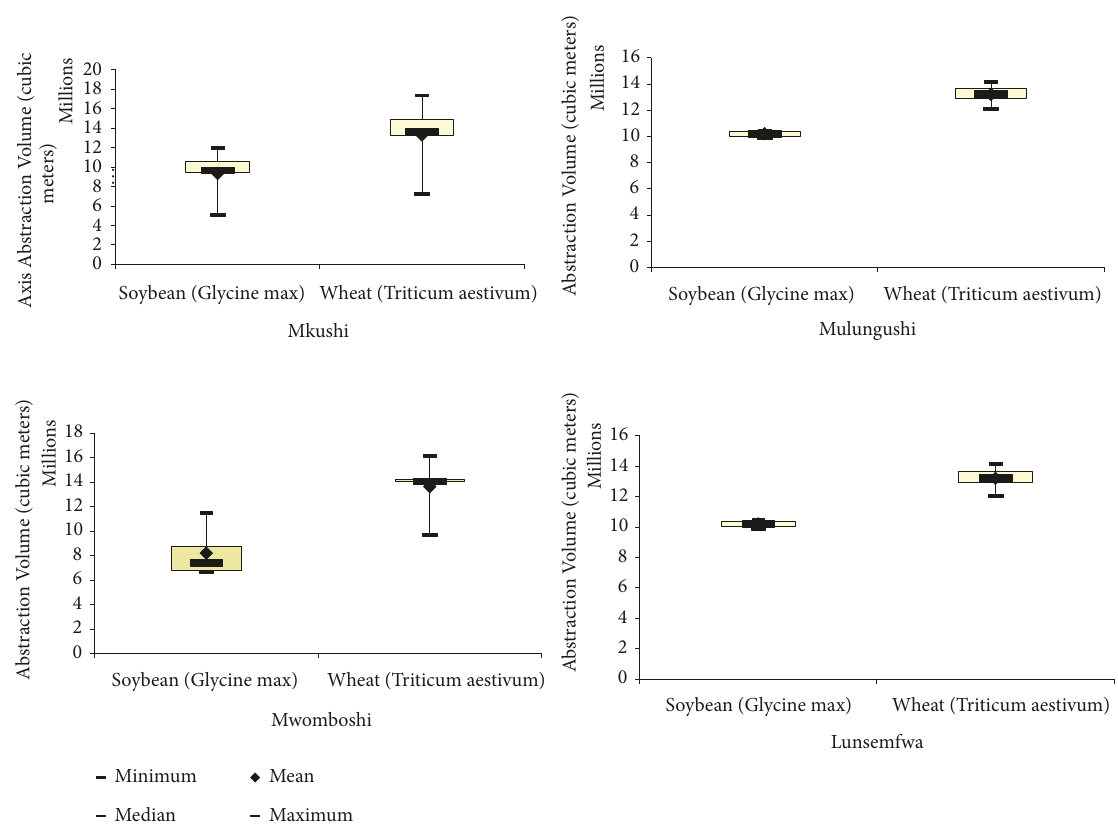
Figure 4: Average wheat and soybean water abstraction from Lunsemfwa.